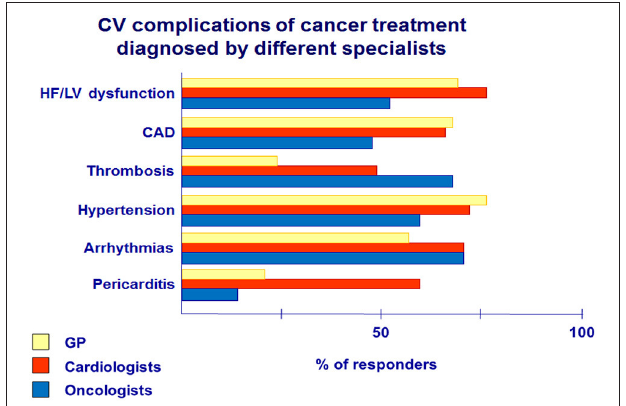
FIGURE 3 | CV complications of cancer treatment diagnosed by different specialists.